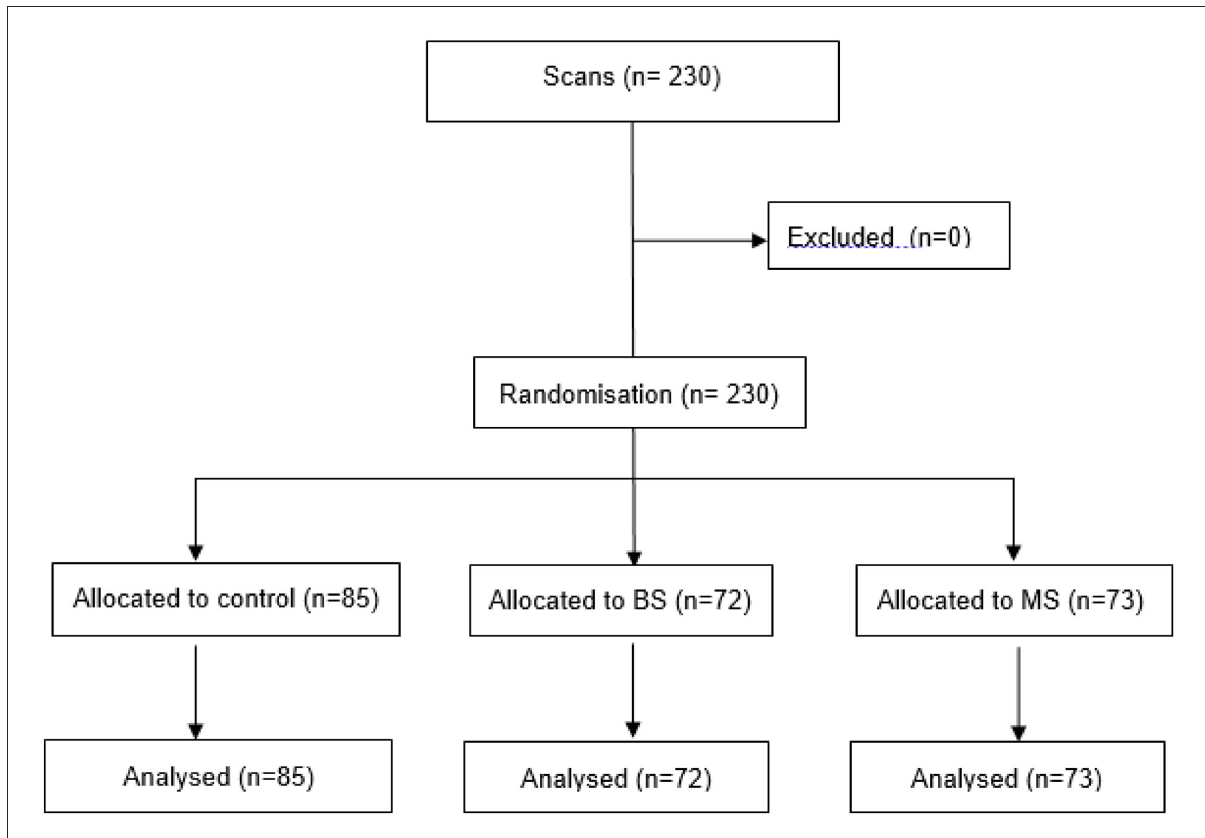
FIGURE1 CONSORT diagram of scans through the trial. Brazilian System (BS), Mexican System (MS).